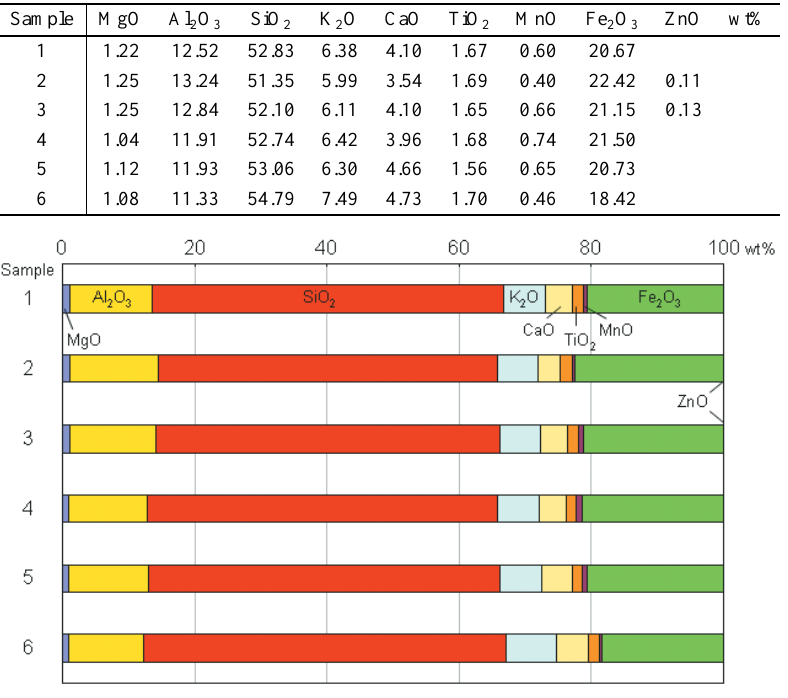
Fig. 6 – X-rayfluorescence analyses (XRF) of soils from six rice fields in Niigata, Japan, show similar chemistry. tom). Optical micrographs showed abundant